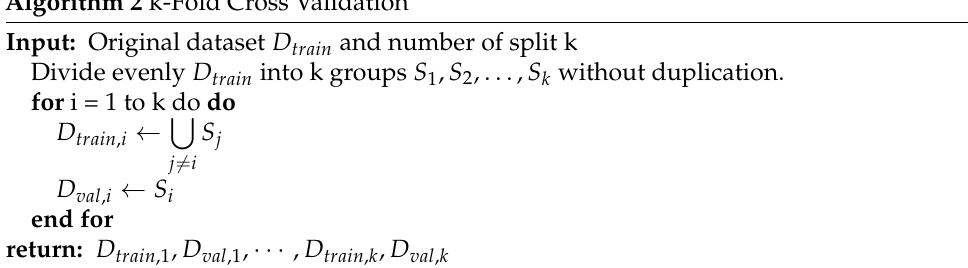
Figure 1. k-Fold Cross Validation. Algorithm 2 k-Fold Cross